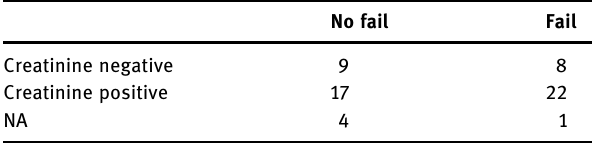
Table 5: Postop creatinine at 12 months